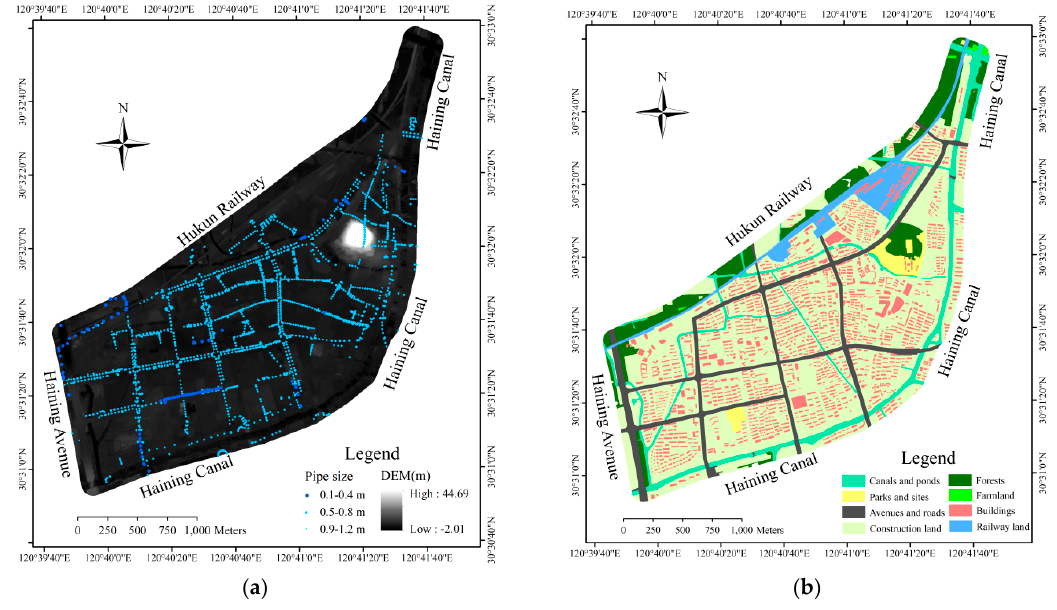
Figure 5. Data description. ( a ) digital elevation model (DEM) and sewer network data; ( b ) land-use map.